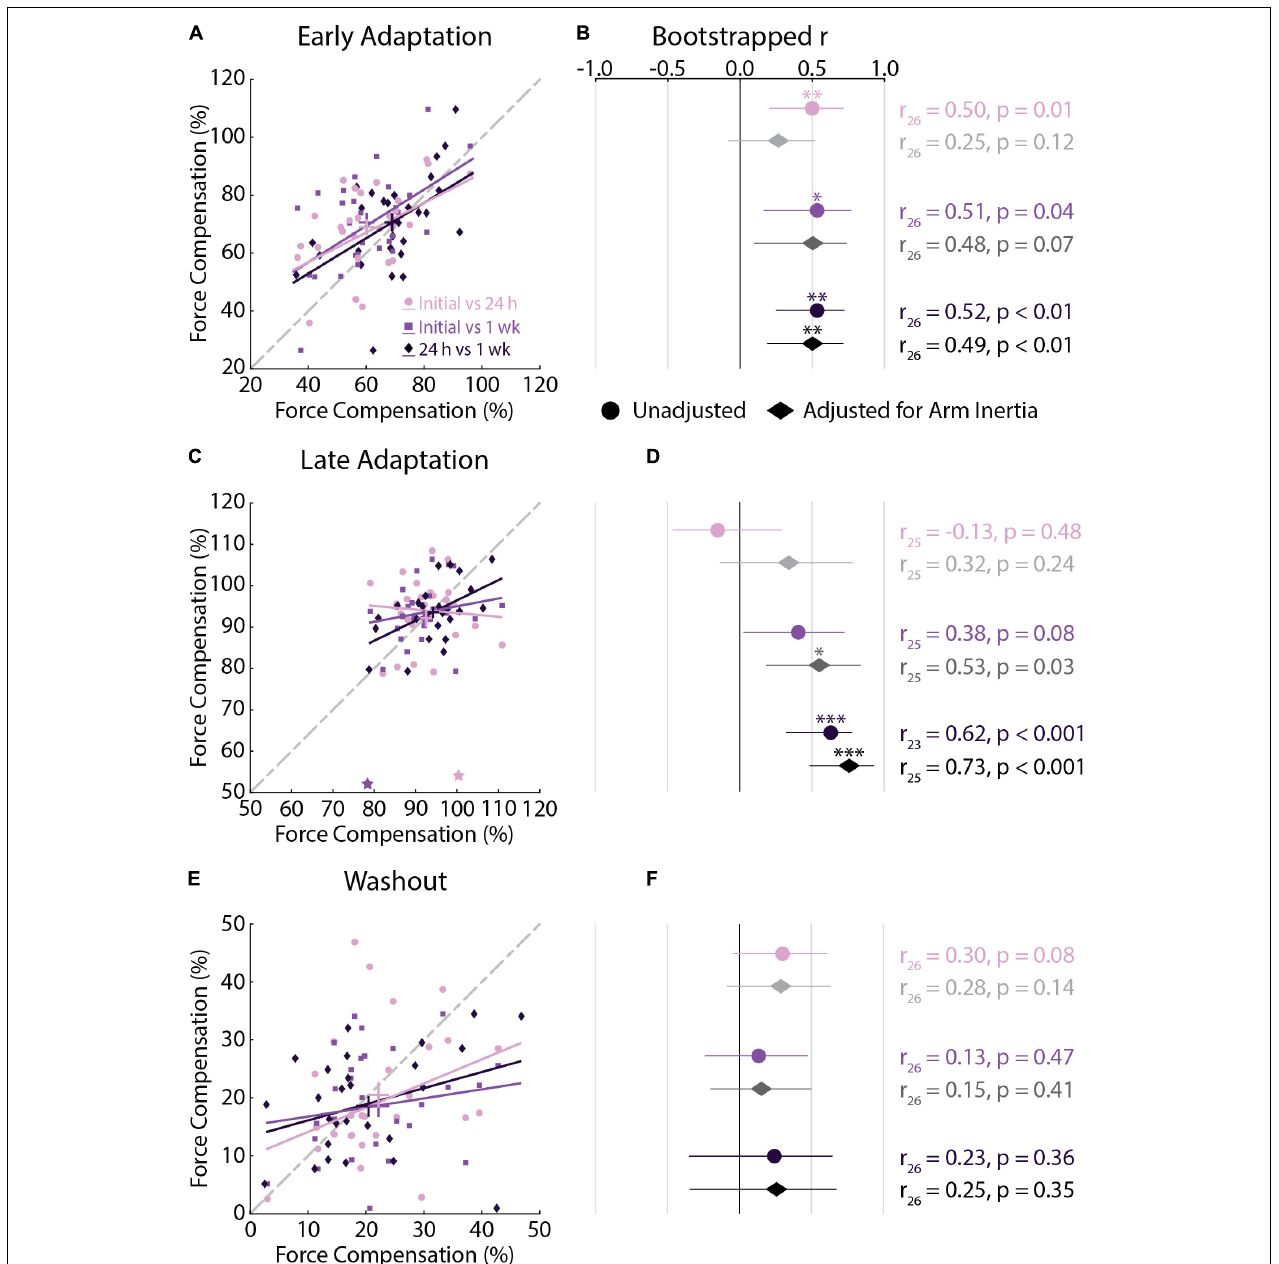
FIGURE 5 | Force compensation correlations across testing sessions ( Experiment 1 ). (A) Correlations between force compensation in Early Adaptation across all sessions. For each correlation, the earlier session is represented on the x -axis and later session on the y -axis. Bars represent the mean and SEM. Trendlines were obtained via robust linear regression and are used for visualization purposes. The dashed gray line represents unity. (B) Mean and 95% confidence intervals (CI) of the bootstrapped Pearson’s r distributions are shown for each correlation (circles) and for the partial Pearson’s correlations adjusted for arm inertia (diamonds). (C,D) Correlations between force compensation in Late Adaptation across all sessions. (E,F) Correlations between force compensation in Washout across all sessions. Data in panels (C–F) are presented in the same manner as panels (A,B) . (C) Stars indicate observations that did not reach the critical value for outlier detection. The results were not different with and without these observations. ∗ p < 0.05, ∗∗ p < 0.01, ∗∗∗ p < 0.001 after Bonferroni corrections (corrected for 3